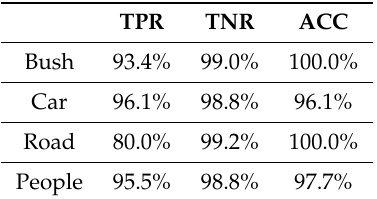
Table 3. Confusion matrix